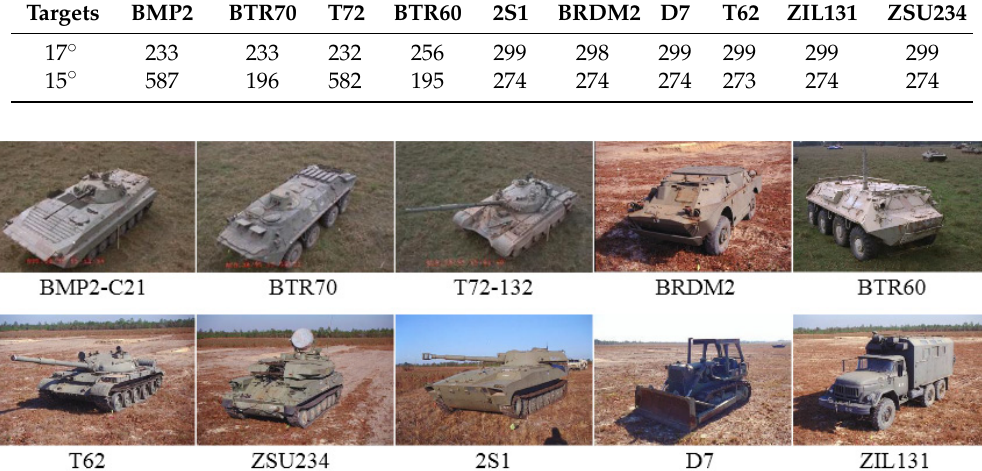
Figure 3. The optical images of the 10 targets. Among them, the T62 and T72 are tanks. The BRDM2,